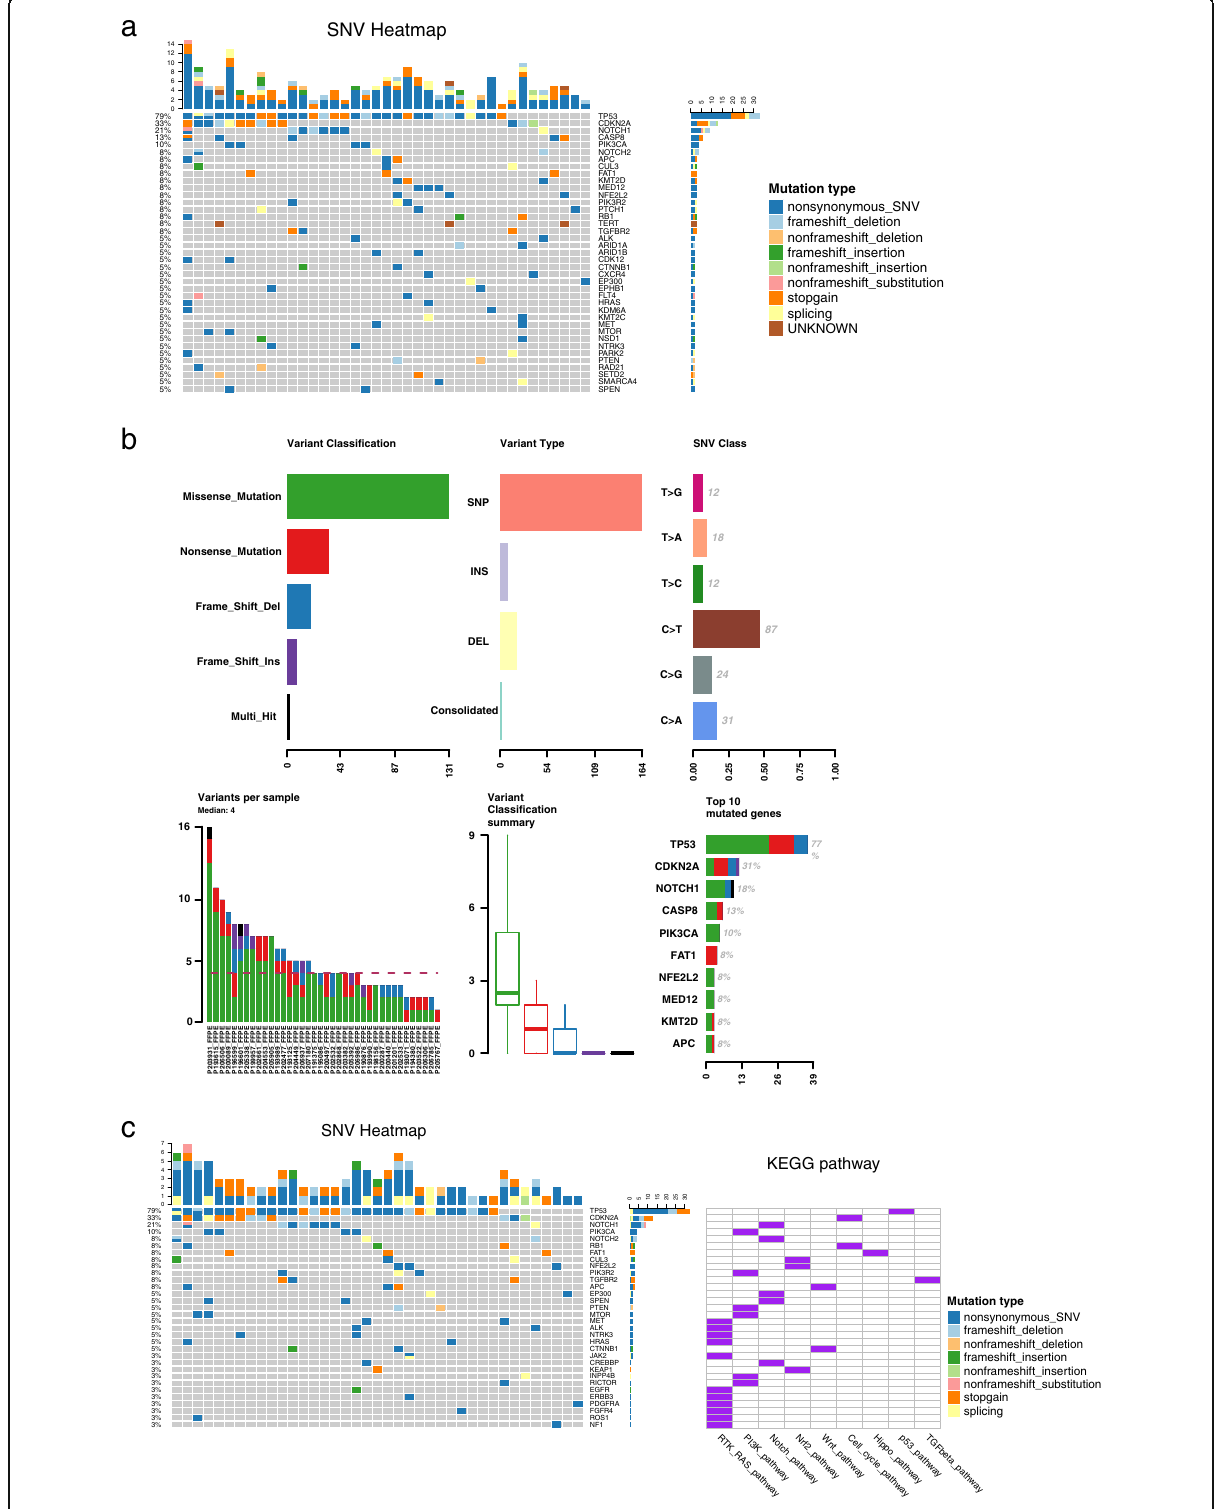
Fig. 1 Genetic mutations in patients with advanced HNSCC after immunotherapy ( n = 39). ( A ) The overall mutational landscape of patients; ( B ) Type analysis of mutated genes; ( C ) Enrichment pathway analysis of mutated